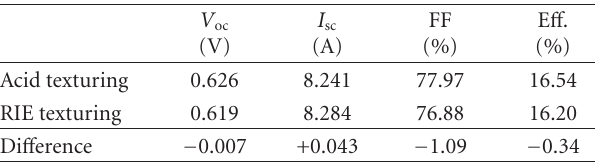
Figure 3: After antireflective coating, reflectance of acidic- and RIE-textured surfaces. Table 1: The average electrical performance of homogeneous emitter mc-Si solar cell with acidic and RIE